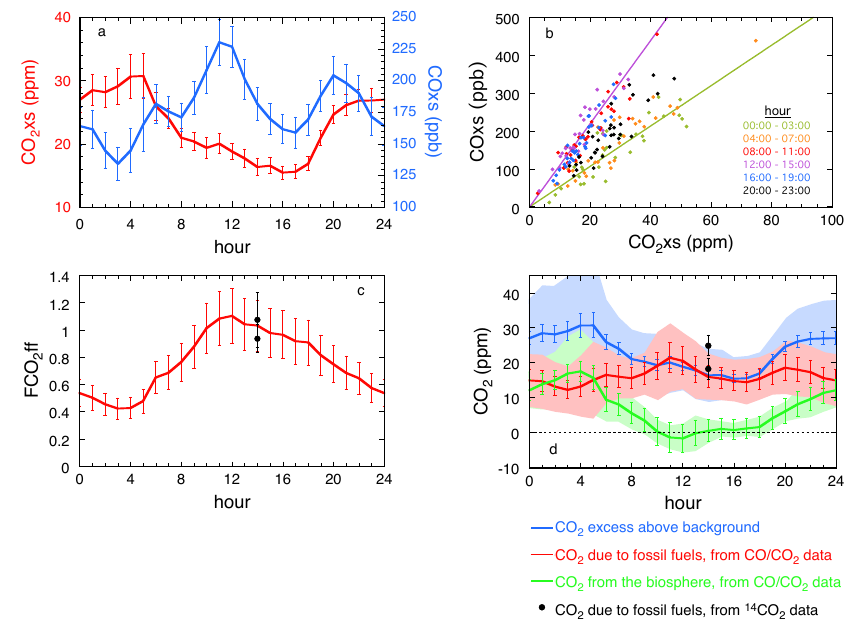
Fig. 4. (a) Excess (xs) CO 2 and CO over background levels (CO 2 background assumed to be constant at 393.1ppm; CO background taken as time-varying, ranging from 96 to 136ppb with an average of 115 ± 10 ppb; Appendix B1 and Novelli et al., 1991). (b) COxs vs. CO 2 xs for hourly averages. Colors indicate time of day. Regression lines for early morning and early afternoon are shown in green and purple, respectively. (c) Diurnal variation of the fraction of fossil fuels ( F ) in the local contribution of CO 2 from CO/CO 2 xs data shown in red. Black dots indicate data from 1 14 CO 2 . (d) Diurnal cycles for CO 2 xs (blue), the amount of CO 2 emitted from fossil fuel combustion (CO 2 ff; red), and the amount of CO 2 emitted from the biosphere (CO 2 bio; green). Black dots indicate data for CO 2 ff from 1 14 CO 2 . Calculations in (c) and (d) assume an emission ratio of CO/CO 2 ff of 0.011 ± 0.002 from Wunch et al. (2009) and backgrounds for CO 2 , CO, and 1 14 CO 2 as described in Appendix B1. Error bars for F ( c ; red), CO 2 ff ( d ; red), and CO 2 bio ( d ; green) reflect the error in the emission ratio (18% relative), for CO 2 xs reflect standard errors ( n = 32), and for CO 2 ff from 1 14 CO 2 reflect errors in measurements and backgrounds. Shaded regions in (d) indicate one standard deviation of the scatter in the hourly